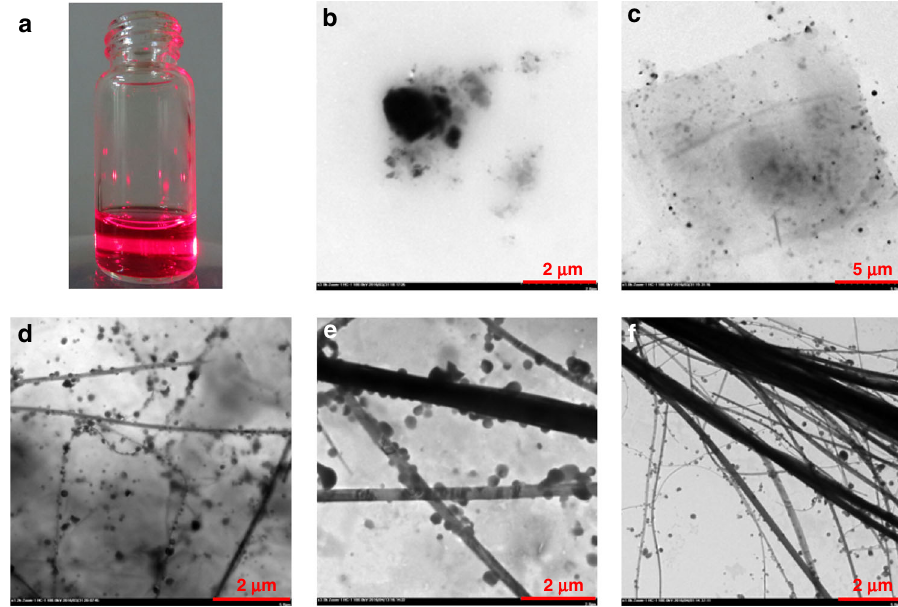
Fig. 9 Structural changes during the self-assembly of 6 3 (cid:129) 10 represented with TEM images investigated at different stages. a The Tyndall effect observed immediately when water was added to a 6 3 (cid:129) 10 solution in THF. b At initial stage, nanoaggregates formed predominantly after 1 h. c The stage that merged into membrane with the volatile of THF after 3 h. d Nanowires around with some nanoparticles appeared after 7 h. e Microwires formed by conglutinating the nanoparticles to the nanowires to increase their diameters after 14 h. f Eventually, the nanowires and microwires bonded together to form stable wire bundles after 3